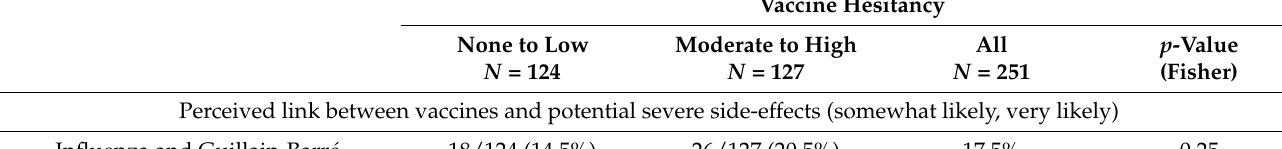
Table 2. Characteristics of generalist physicians based on their practices and their opinions on vaccination. Vaccine hesitancy degree was determined after hierarchical cluster